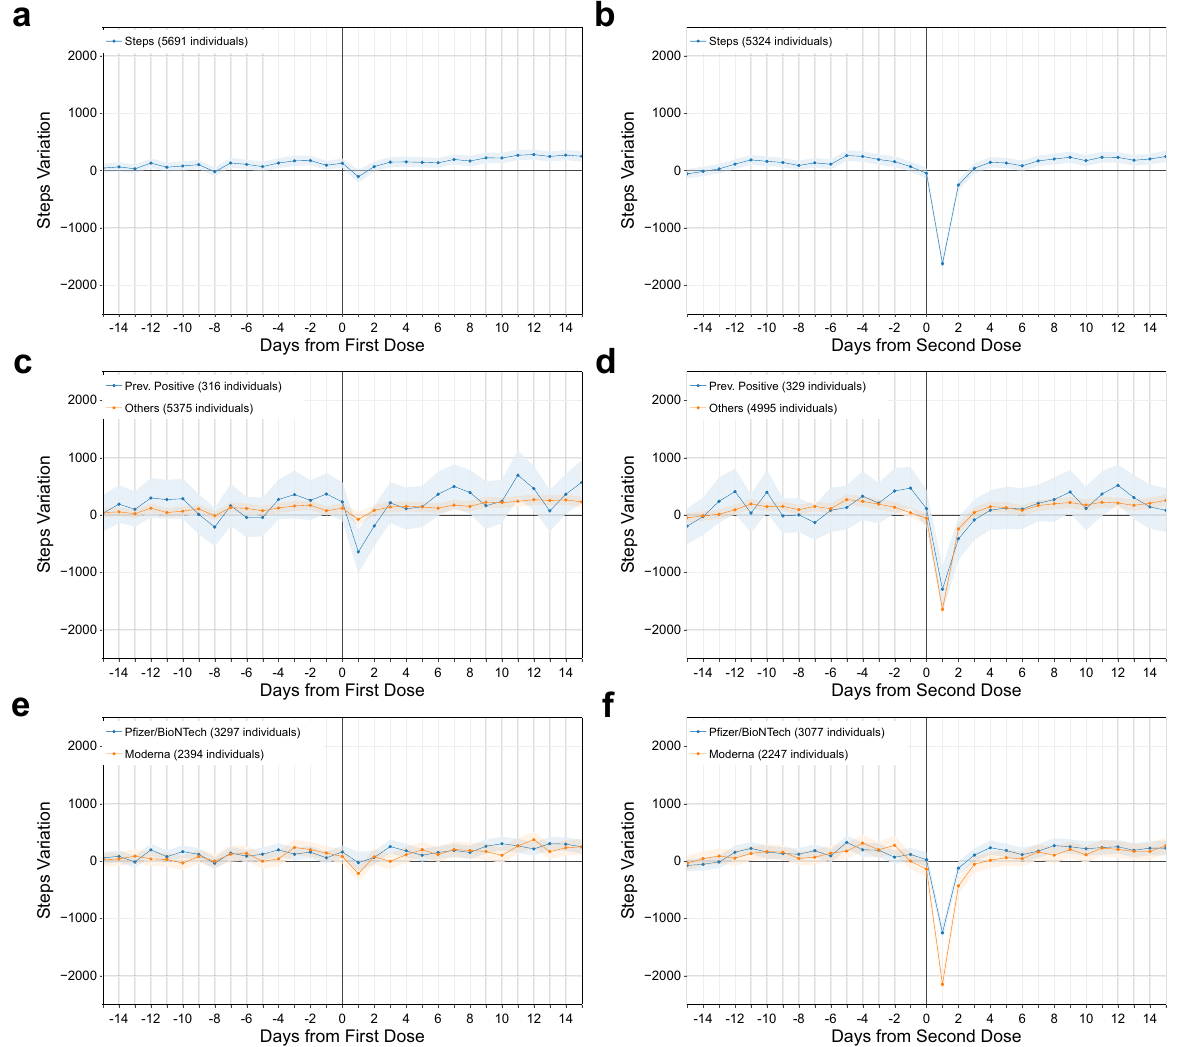
Fig. 5 Activity metric changes post vaccination. Mean and 95% con fi dence interval of the absolute individual changes in activity metric (number of steps) with respect to the individual baseline around the date of vaccination (day 0), for the fi rst dose of the vaccine ( a ), ( c ), ( e ), and for the second dose ( b ), ( d ), ( f ), for all individuals vaccinated ( a ), ( b ), for individuals previously tested positive to COVID-19 ( c ), ( d ), and for individuals vaccinated with the P fi zer-BioNTech or Moderna vaccines ( e ), ( f